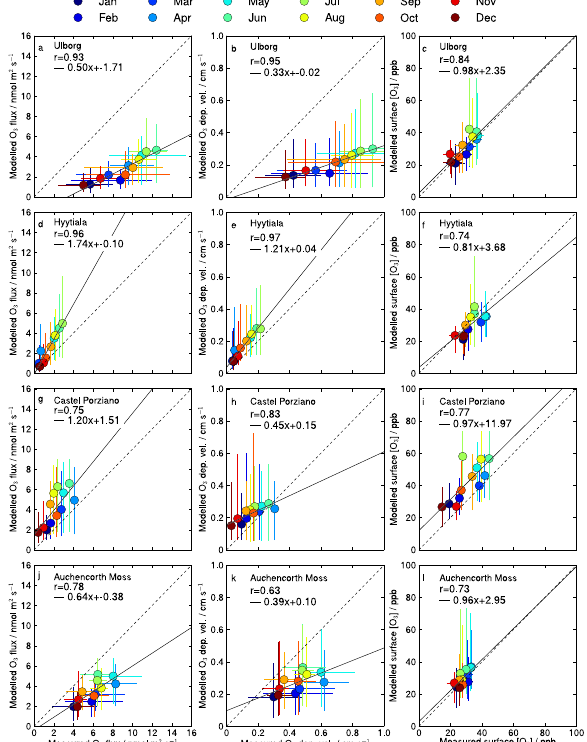
Figure 6. Comparison of observed and modelled monthly average O 3 dry deposition fluxes, O 3 dry deposition velocities and surface O 3 at European measurement sites. Individual sites are shown by row for Ulborg (a – c) , Hyytiala (d – f) , Castel Porziano (g–i) and Auchencorth Moss (j – l) . Observed and modelled fluxes at each site are compared directly in the left hand column, deposition veloci- ties are shown in the middle column, and surface O 3 is compared in the right hand column. Vertical bars represent the range across the models and horizontal bars represent the interannual range in the observations, where available.